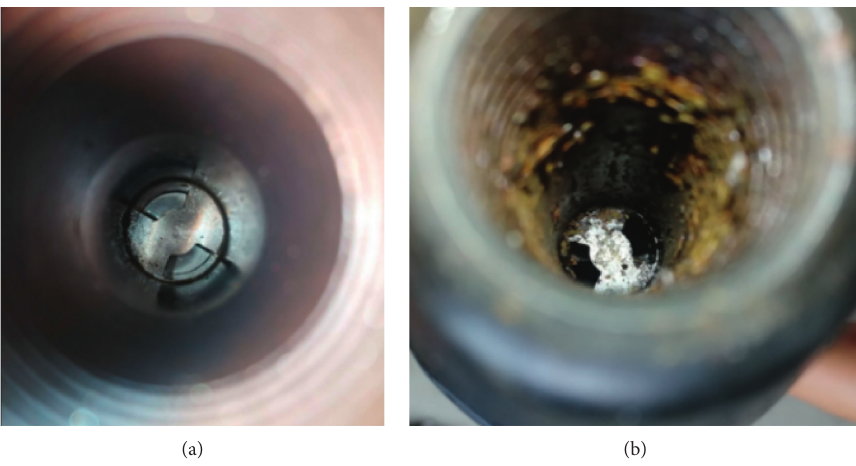
Figure 13: Valve opening before field production regulation test.